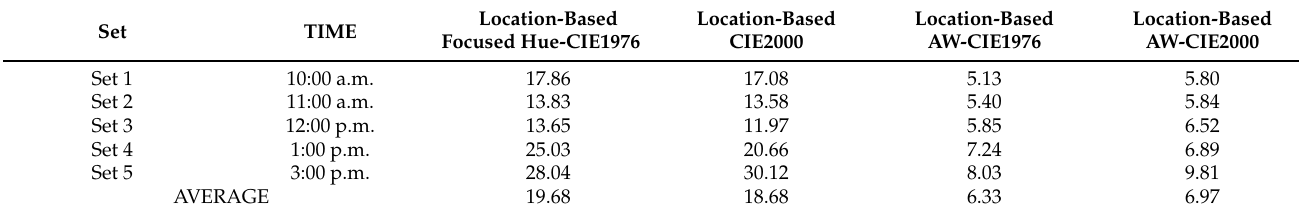
Table 6. Google Pixel average prediction rank using CIELAB colour model and CIE1976 and CIE2000 distance functions. Location-Based—Prediction using only prominent soil colours in Australian topsoils. AW—Proposed weight difference from Table